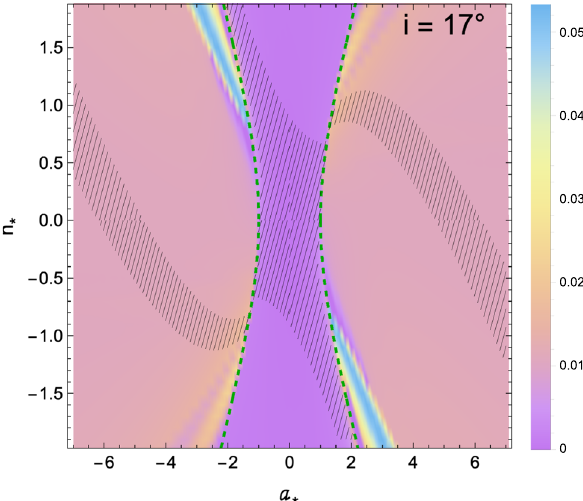
Fig. 6 Constraints on NUT parameter ( n ∗ ) and Kerr parameter ( a ∗ ) obtained by using the EHT results for M87* shadow and assuming an inclination angle of i = 17 ◦ . The plane is divided into KTN BH and KTNNSregionsbythetwothindashedgreenlines,i.e.,theintermediate portion of the two green lines implies the KTN BH region whereas rest of the plane implies the KTN NS region. The entire (colored) region of this plot represents those with circularity Δ d (cid:2) 10%, as required by the EHT observations for M87*. The combinations of a ∗ and n ∗ in the hatched region can be regarded as the allowed region for M87*. This figure shows that M87* could contain gravitomagnetic monopole n ∗ , in whichcasetheupperlimitof n ∗ cannotbegreaterthan1 . 1,i.e., n ∗ (cid:2) 1 . 1 for the prograde rotation ( a ∗ > 0), whereas the lower limit of n ∗ cannot be less than − 1 . 1, i.e., n ∗ (cid:3) − 1 . 1 for the retrograde rotation ( a ∗ < 0). Thisfigurealsosuggeststhatthemeasurementoftheshadowasymmetry with 1% of accuracy can help to break the degeneracy between a BH and a NS, in general. Even if the KTN NS is falsifiable, M87* could still be described as a KTN BHwith the upper limitof n ∗ as n ∗ < 0 . 9 in case of the prograde rotation, and the lower limit of n ∗ as n ∗ > − 0 . 9 in case of the retrograde rotation. Here we plot for a limited parameter space. For a general large parameter space, the thin Yellow-Cyan regions, adjacent to the green dashed lines of Quadrants II & IV, are broadened for increasing the value of | n ∗ | and the black hatched region of NS can be overlapped with this region. Moreover, the value of Δ d in the black hatched regions of NS is not always bounded within the value 10%, but it can also be equal to or greater than 10% (i.e., Δ d (cid:5) 10% is possible in the black hatched region of NS) depending on the values of a ∗ & n ∗ in the general parameter space. See Sects. 3.2 and 4 for